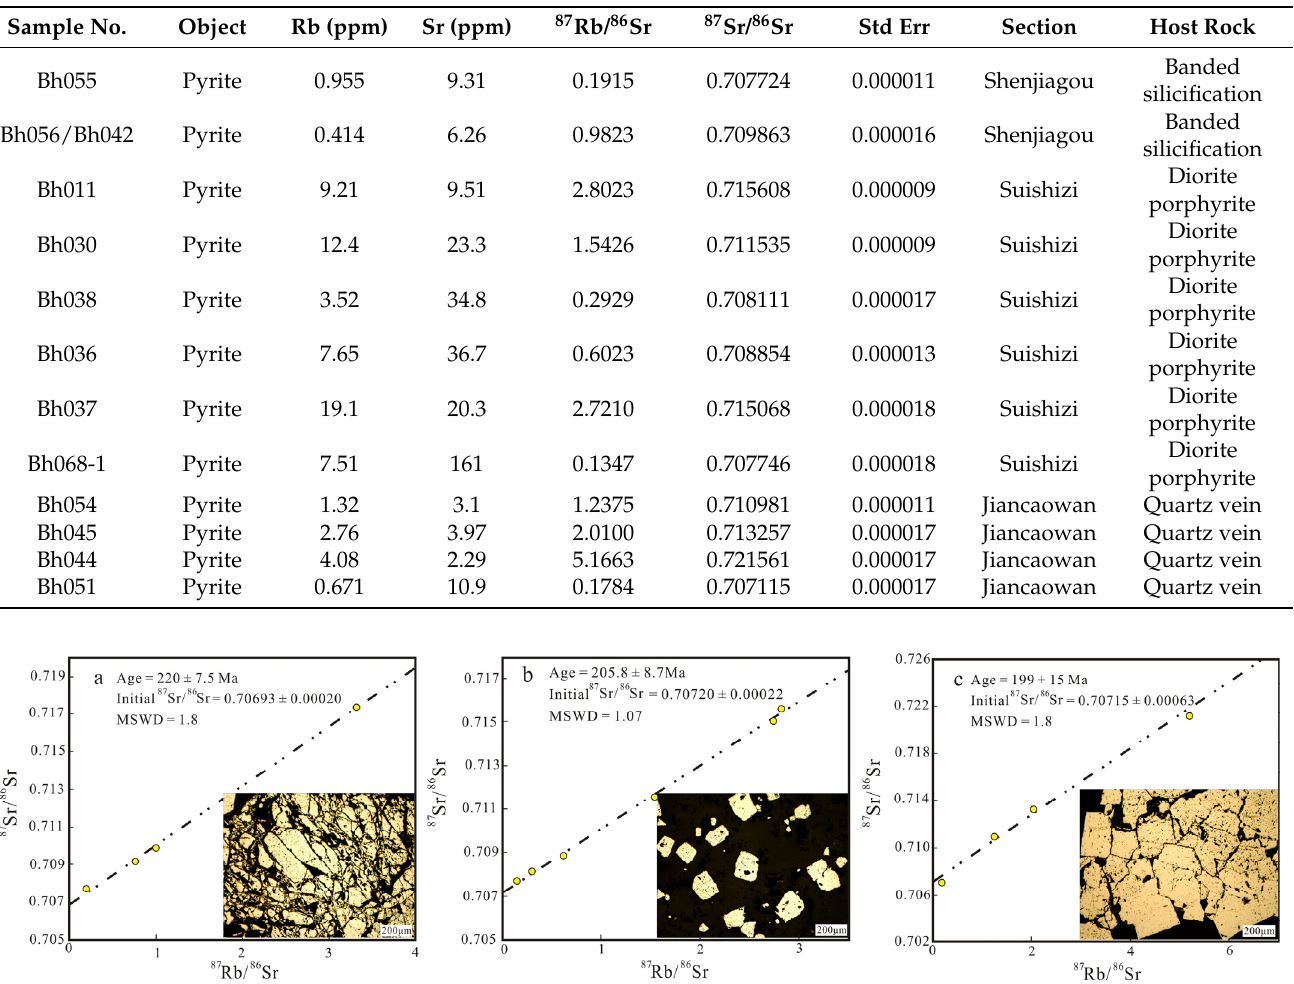
Figure 8. Rb–Sr isochrons of pyrite from banded silicification ( a ), diorite porphyrite ( b ), and quartz veins ( c ). Table 5. Rb-Sr isotopic dating of pyrite samples from Liziyuan gold deposit.